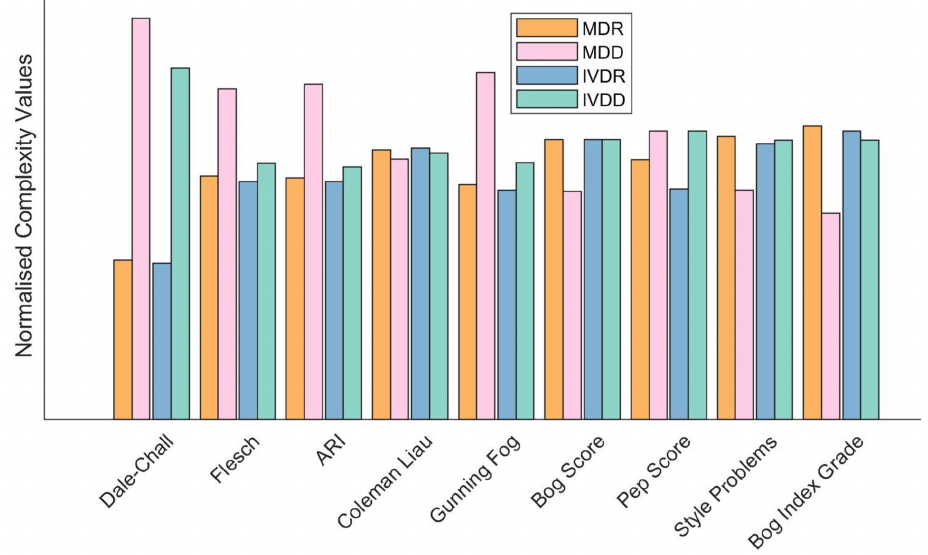
Figure 2. Readability scores for the MDR, MDD, IVDR and IVDD. Outcomes consist of the Dale–Chall Readability score, Automated Readability Index (ARI), Coleman Liau Index, Gunning Fog, Flesch Kincade Grade and Bog